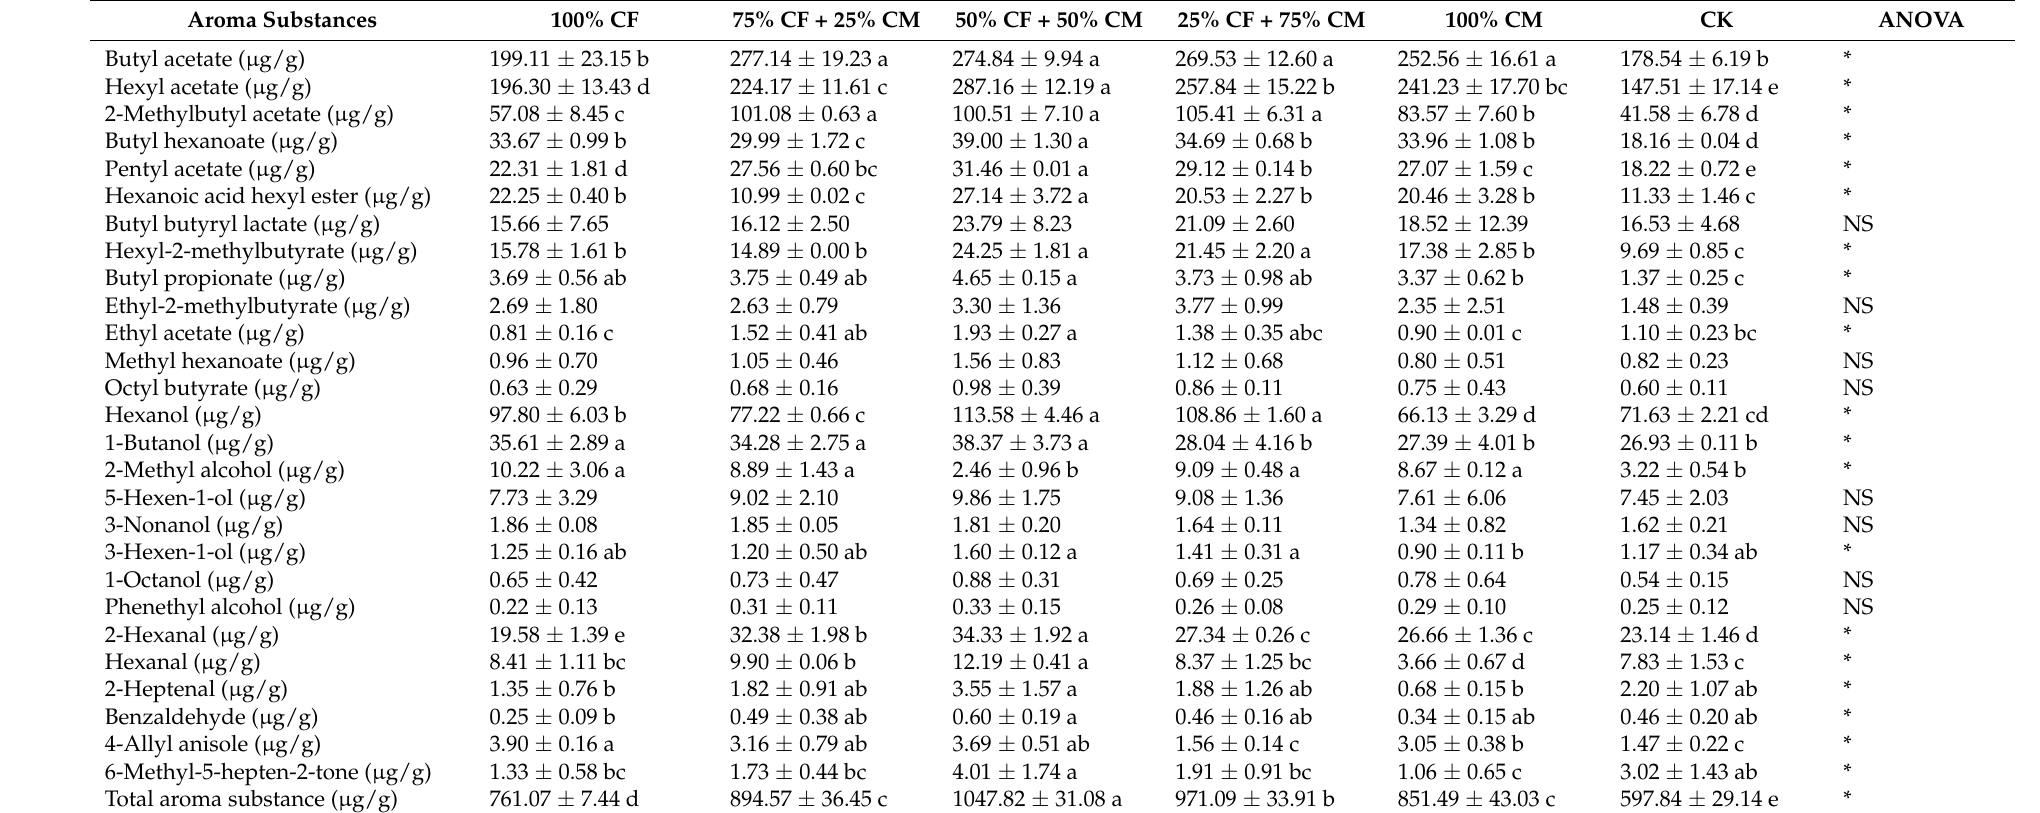
Table 5. Effect of different ratios of cow manure and chemical fertilizers on fruit aroma